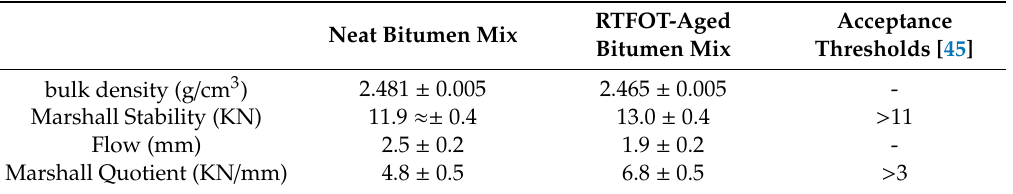
Table 3. Marshall Stability for asphalts concretes prepared with neat and RTFOT-Aged Bitumen (average of six independent samples). In parenthesis the standard deviation is